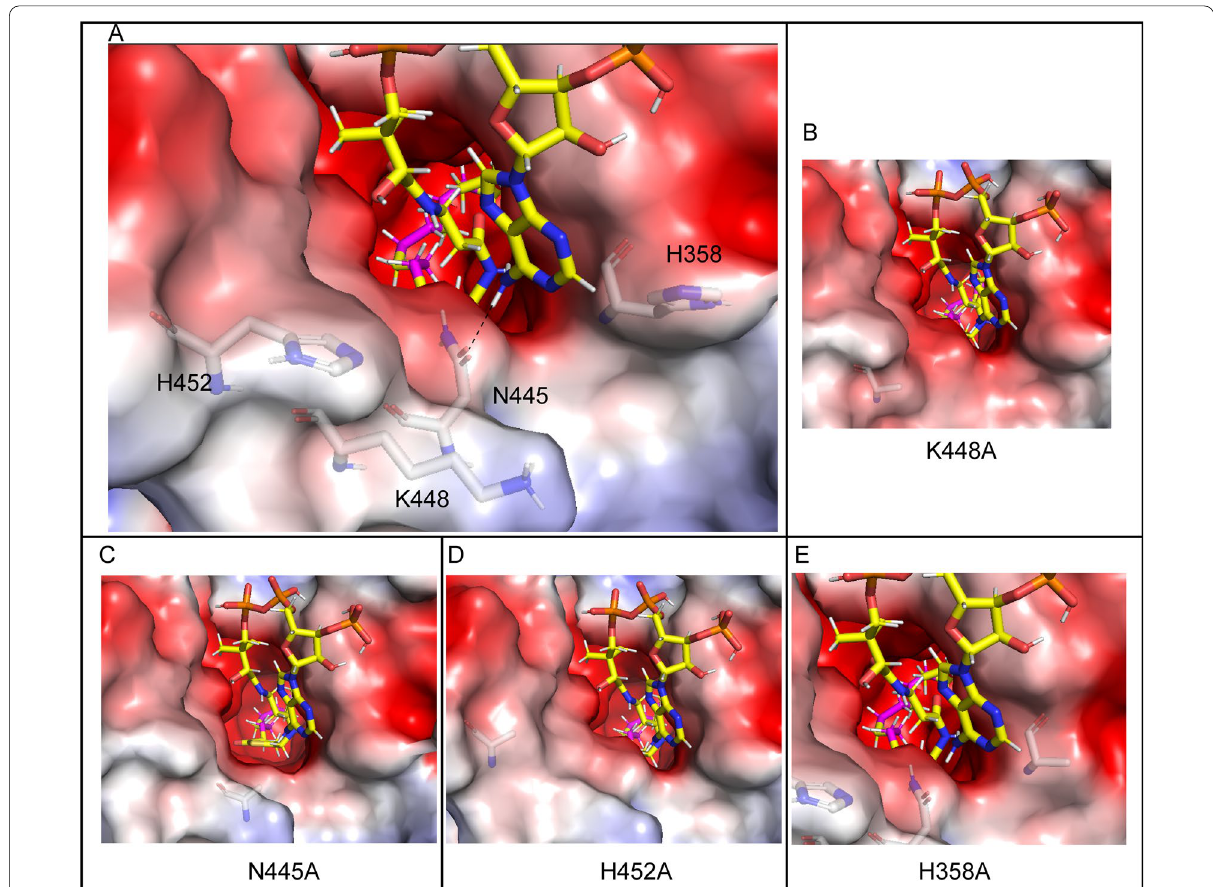
Fig. 6 The key amino acid site for Mp FADS6 binding to the substrate head group ( A ). Conformational changes in K448A ( B ), N445A ( C ), N452A ( D ), and H358A ( E ). The yellow stick indicates the mesh of substrate